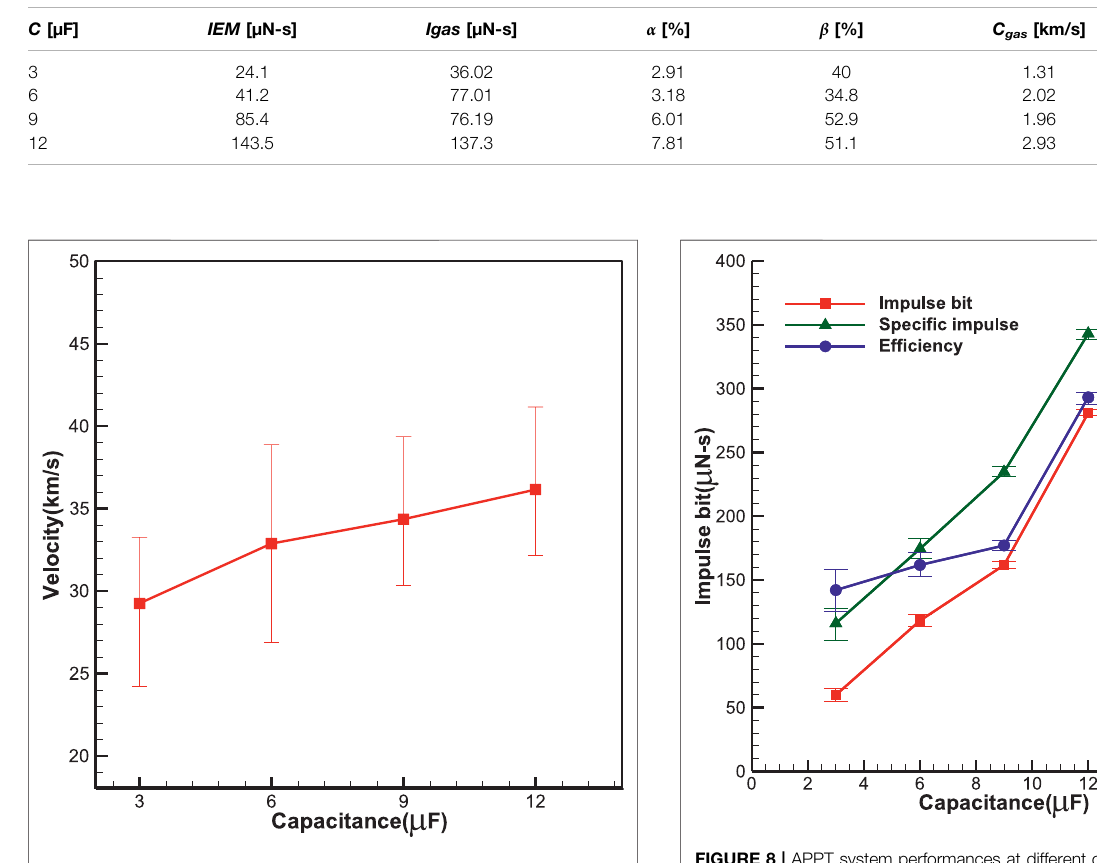
FIGURE 8 | APPT system performances at different capacitances.